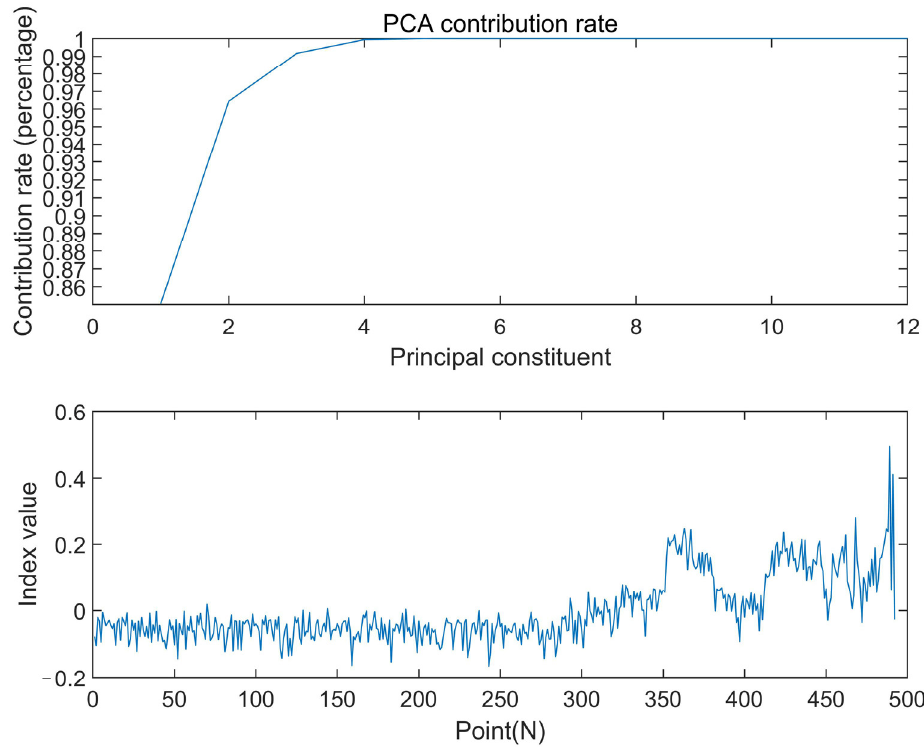
Figure 5. PCA index of the training